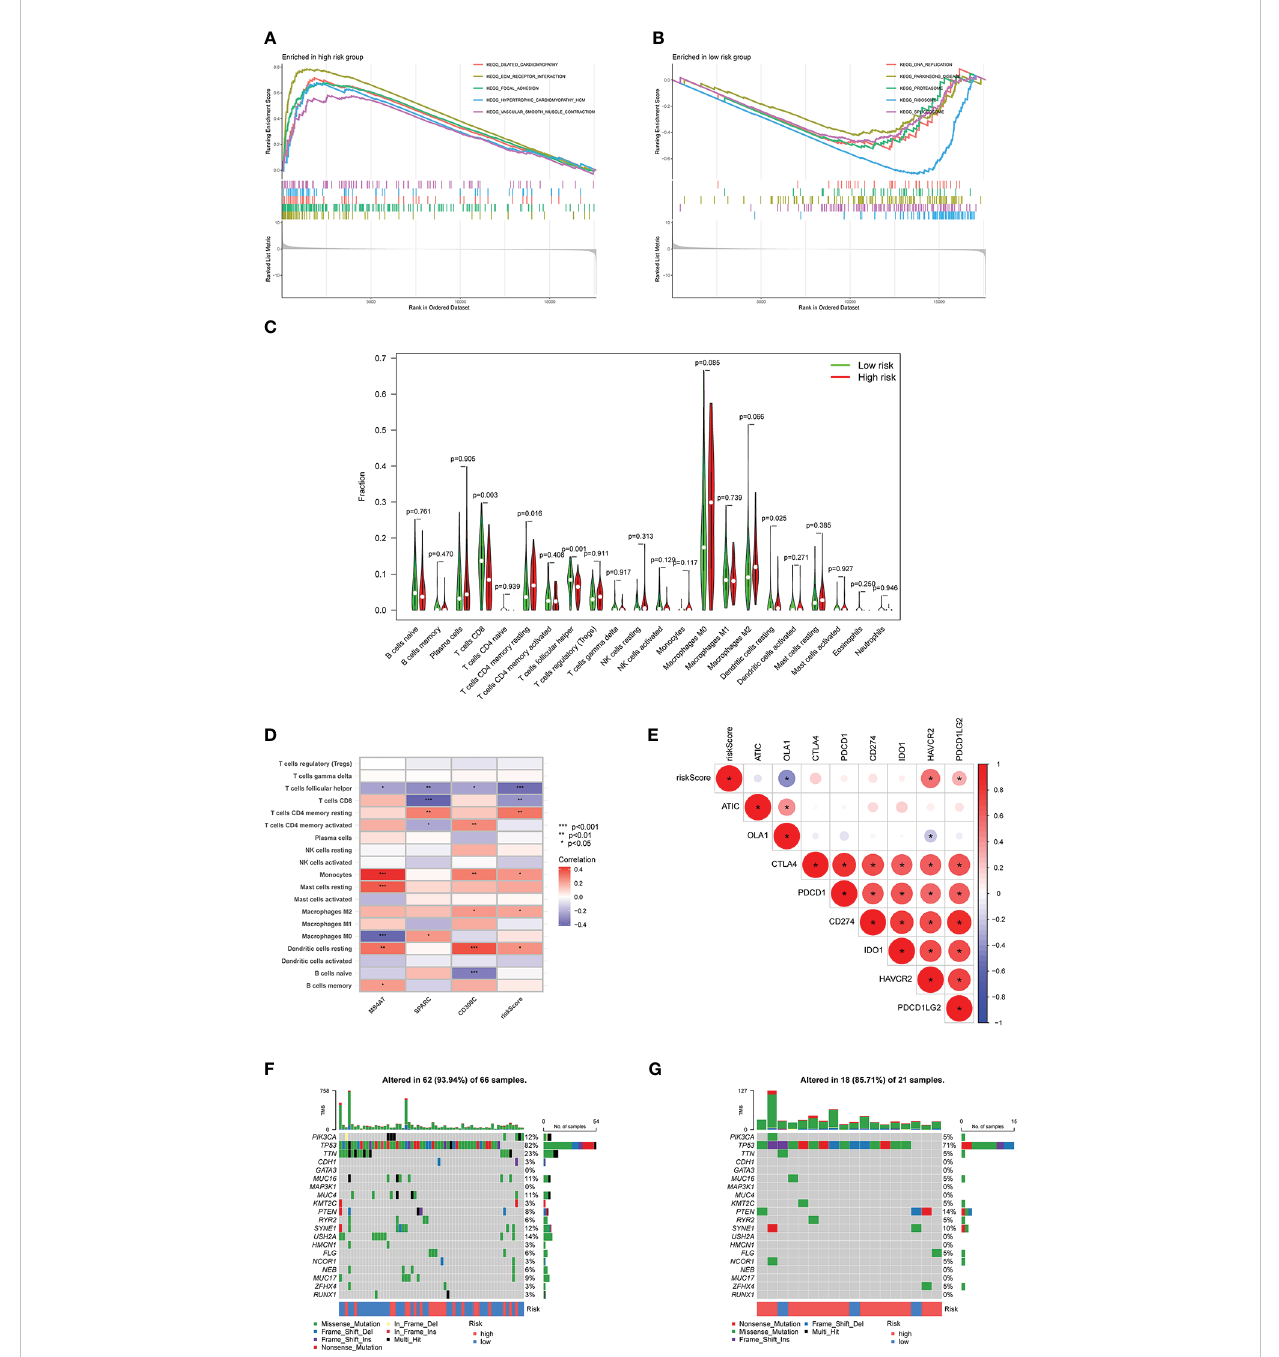
FIGURE 8 Relationship between risk score and immunity: A and B show the results of GSEA analysis, C shows the in fi ltration results of immune cells, D shows the correlation between MS4A7, SPARC and CD300C with immune cells in fi ltration, E shows correlation between immune checkpoints and risk score, F and G show the waterfall diagram based on risk scores and tumor mutational burden. * means p<0.05, **means p<0.01, *** means